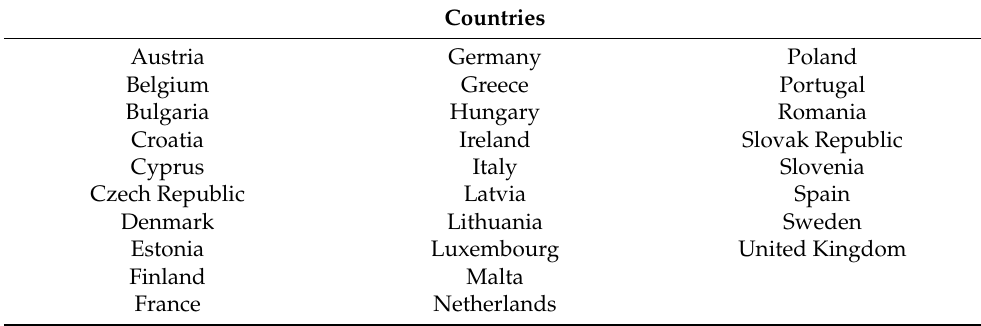
Table 1. List of analysed